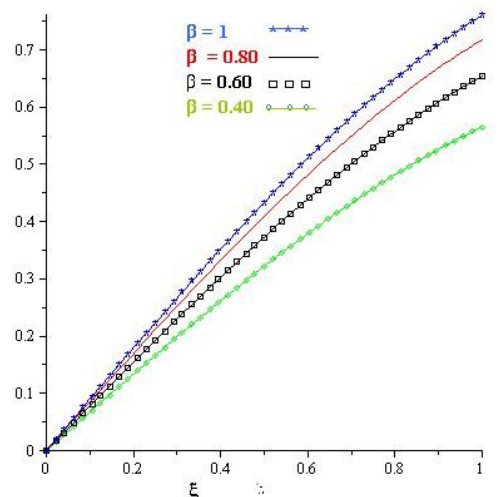
Figure 8. Variational homotopy perturbation transform method solution of example 4.4 at different fractional order β = 1, 0.8, 0.6,